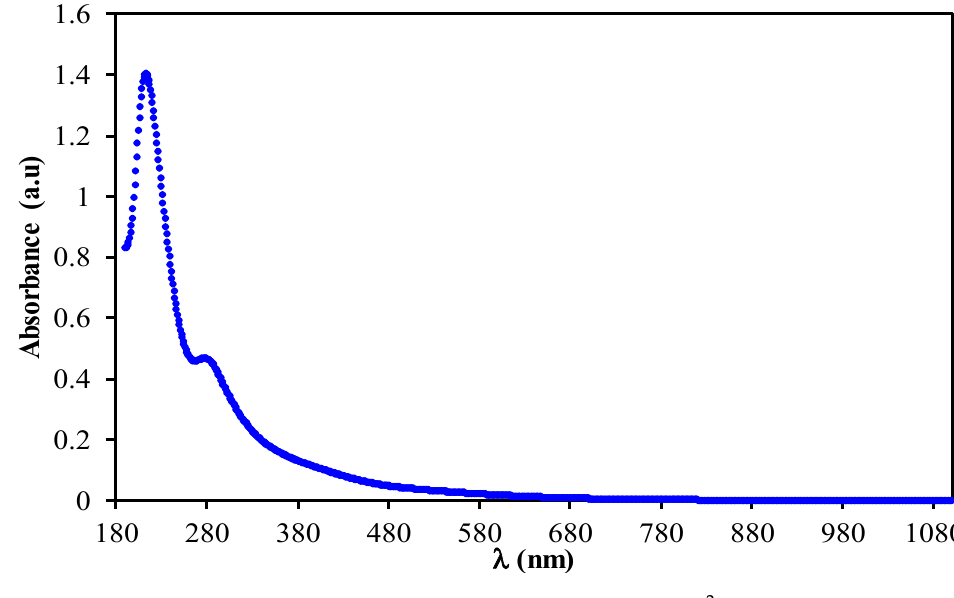
Figure 1. Absorption spectrum for colloidal suspension of Ni 2+ -metal complex.